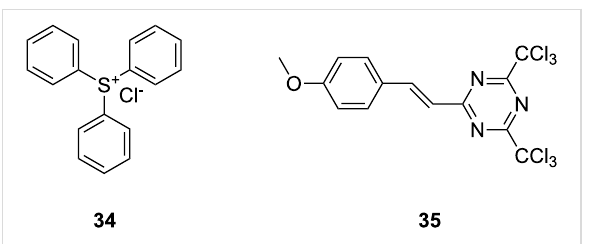
Figure 13: Photoacid generators for photoinduced metathesis.